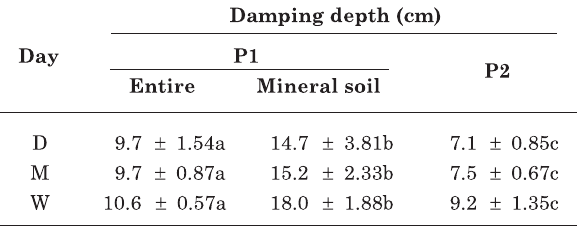
On each day, values followed by different letters are significantly different (*p <